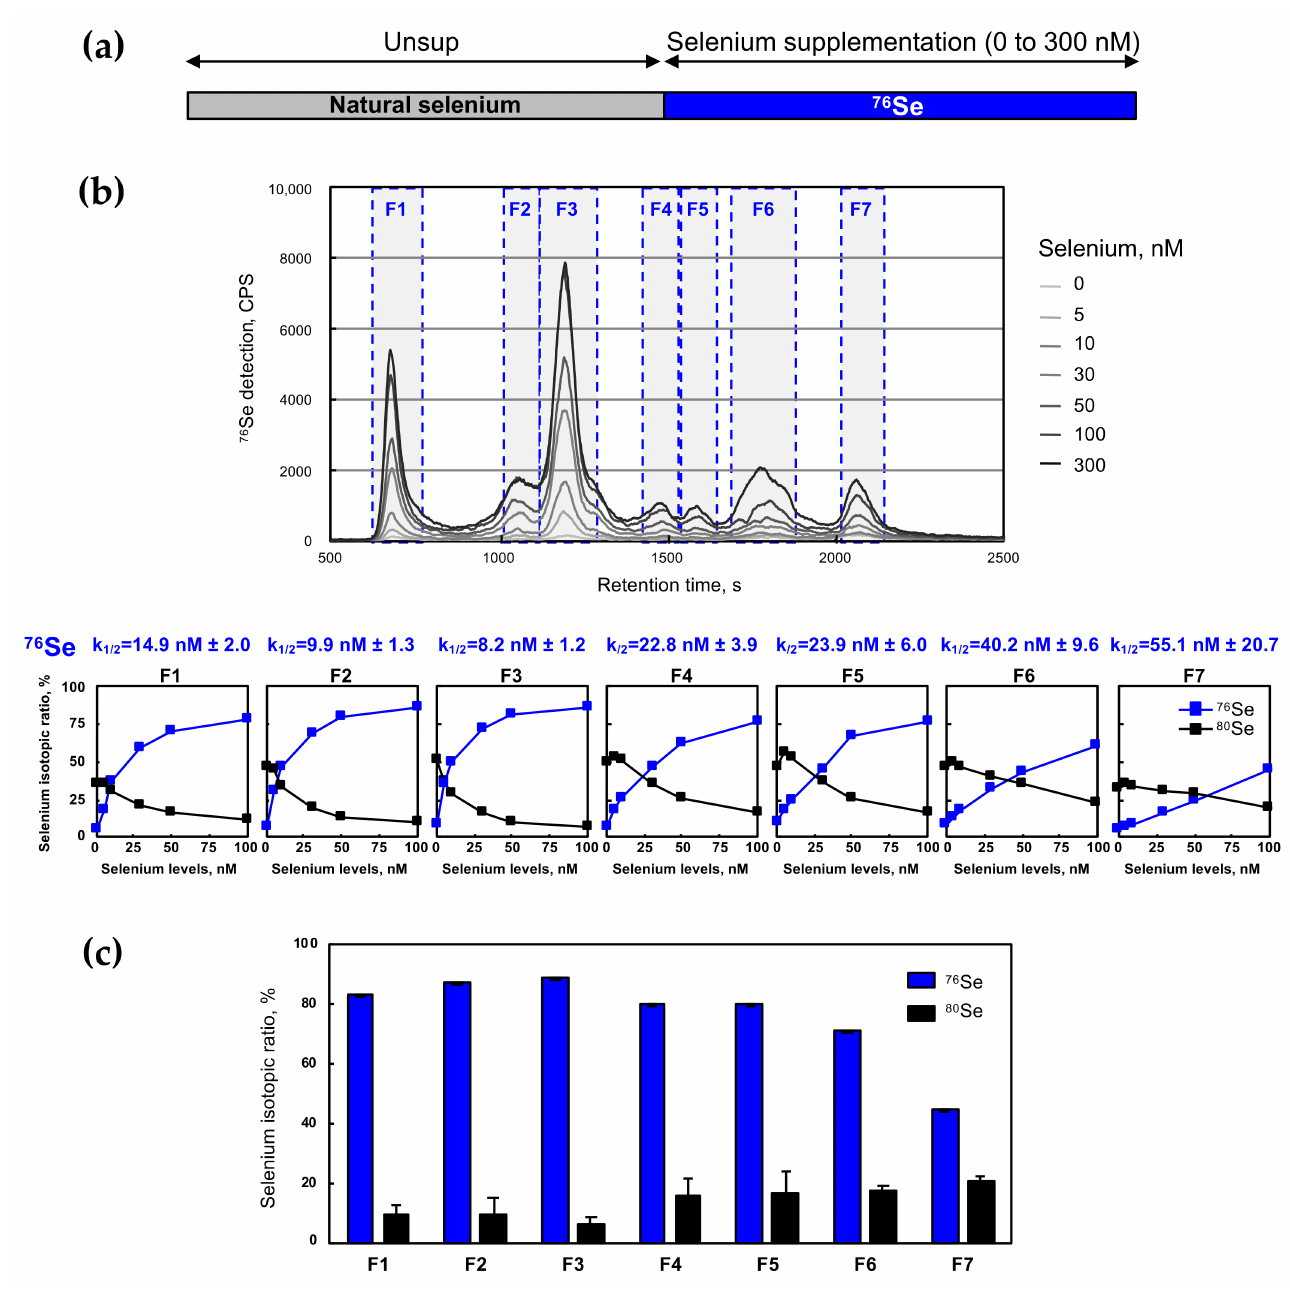
Figure 2. Analysis of HEK193 cells labeled with increasing concentrations of 76 Se by SEC ICP MS. ( a ) Cells were grown for three days in a Dpl medium prior to being plated in fresh medium with increasing concentrations of 76 Se enriched selenium (from 0 to 300 nM range). ( b ) The different cellular extracts were fractionated by SEC and all selenium isotopes ( 74 Se, 76 Se, 77 Se, 78 Se, 80 Se and 82 Se) followed by ICP MS detection. The SEC elution profile for 76 Se is shown in the bottom panel for the various cellular extracts. The isotopic pattern was analyzed in the seven identified fractions, as indicated by dashed boxes (F1 to F7). The dose–response curves for 76 Se abundance in each fraction as a function of selenium levels in the culture media were fitted as described in experimental procedures. The results for k 1/2 for 76 Se labeling are indicated on top of each graph. For clarity, only 76 Se and 80 Se are represented in blue and black squares, respectively, at a smaller scale of selenium levels (0 to 100 nM). ( c ) The selenium isotopic ratio is represented for the two most abundant isotopes ( 76 Se and 80 Se), for each fraction (F1 to F7), in the condition where 300 nM 76 Se was